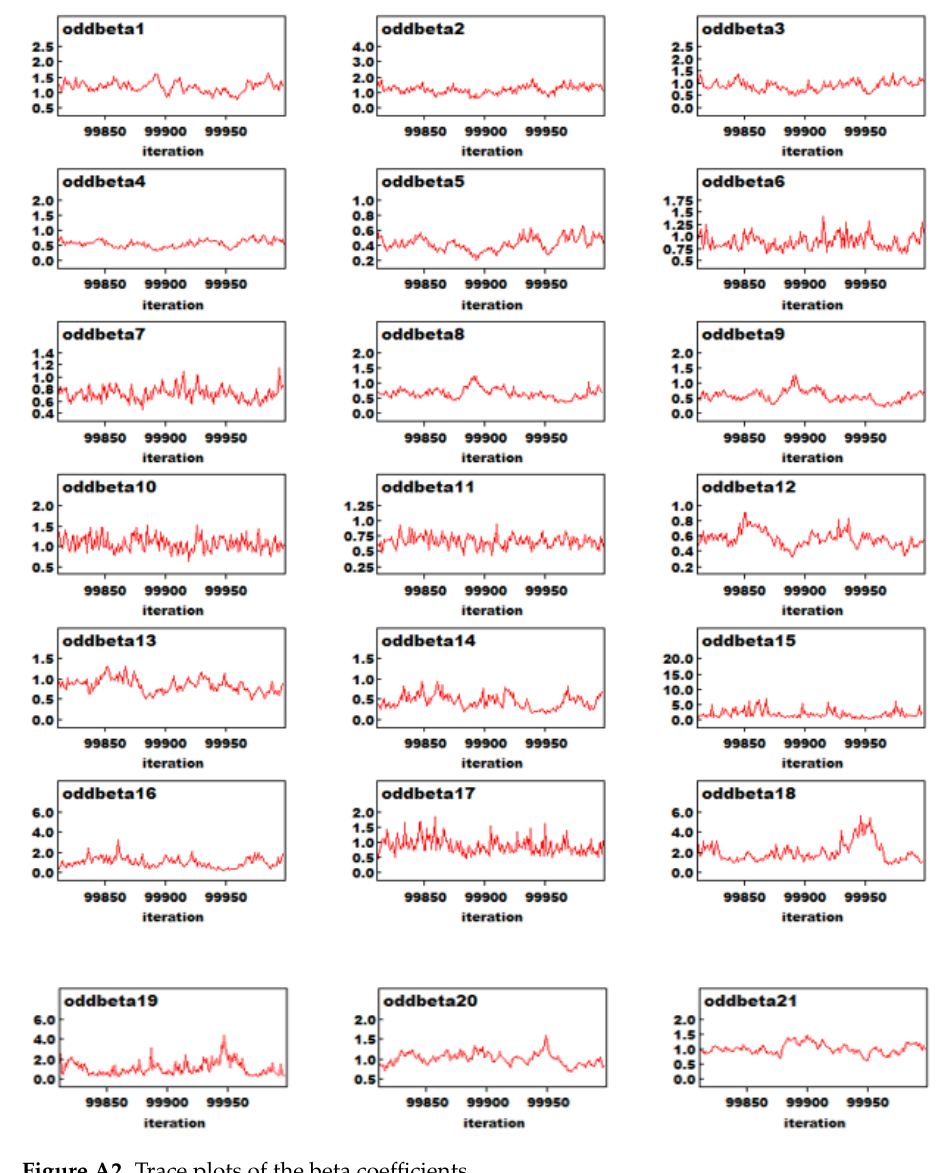
Figure A2. Trace plots of the beta coefficients.